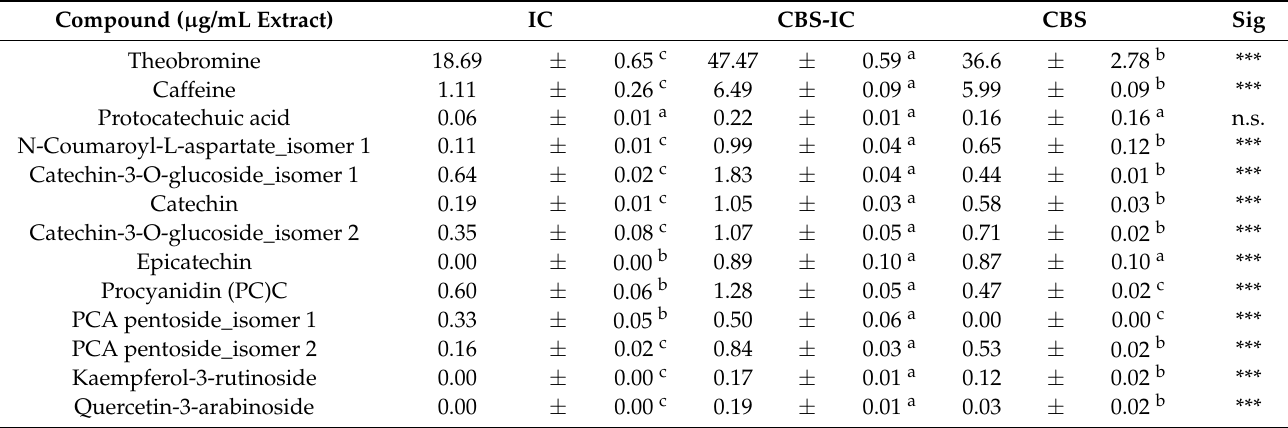
Table 2. Main components identified and quantified by high-performance liquid chromatography (HPLC) in solutions yielded after gastrointestinal digestion of plain ice cream (IC), ice cream enriched with 4% CBS (CBS-IC), and CBS (CBS). Compound ( µ g/mL Extract)